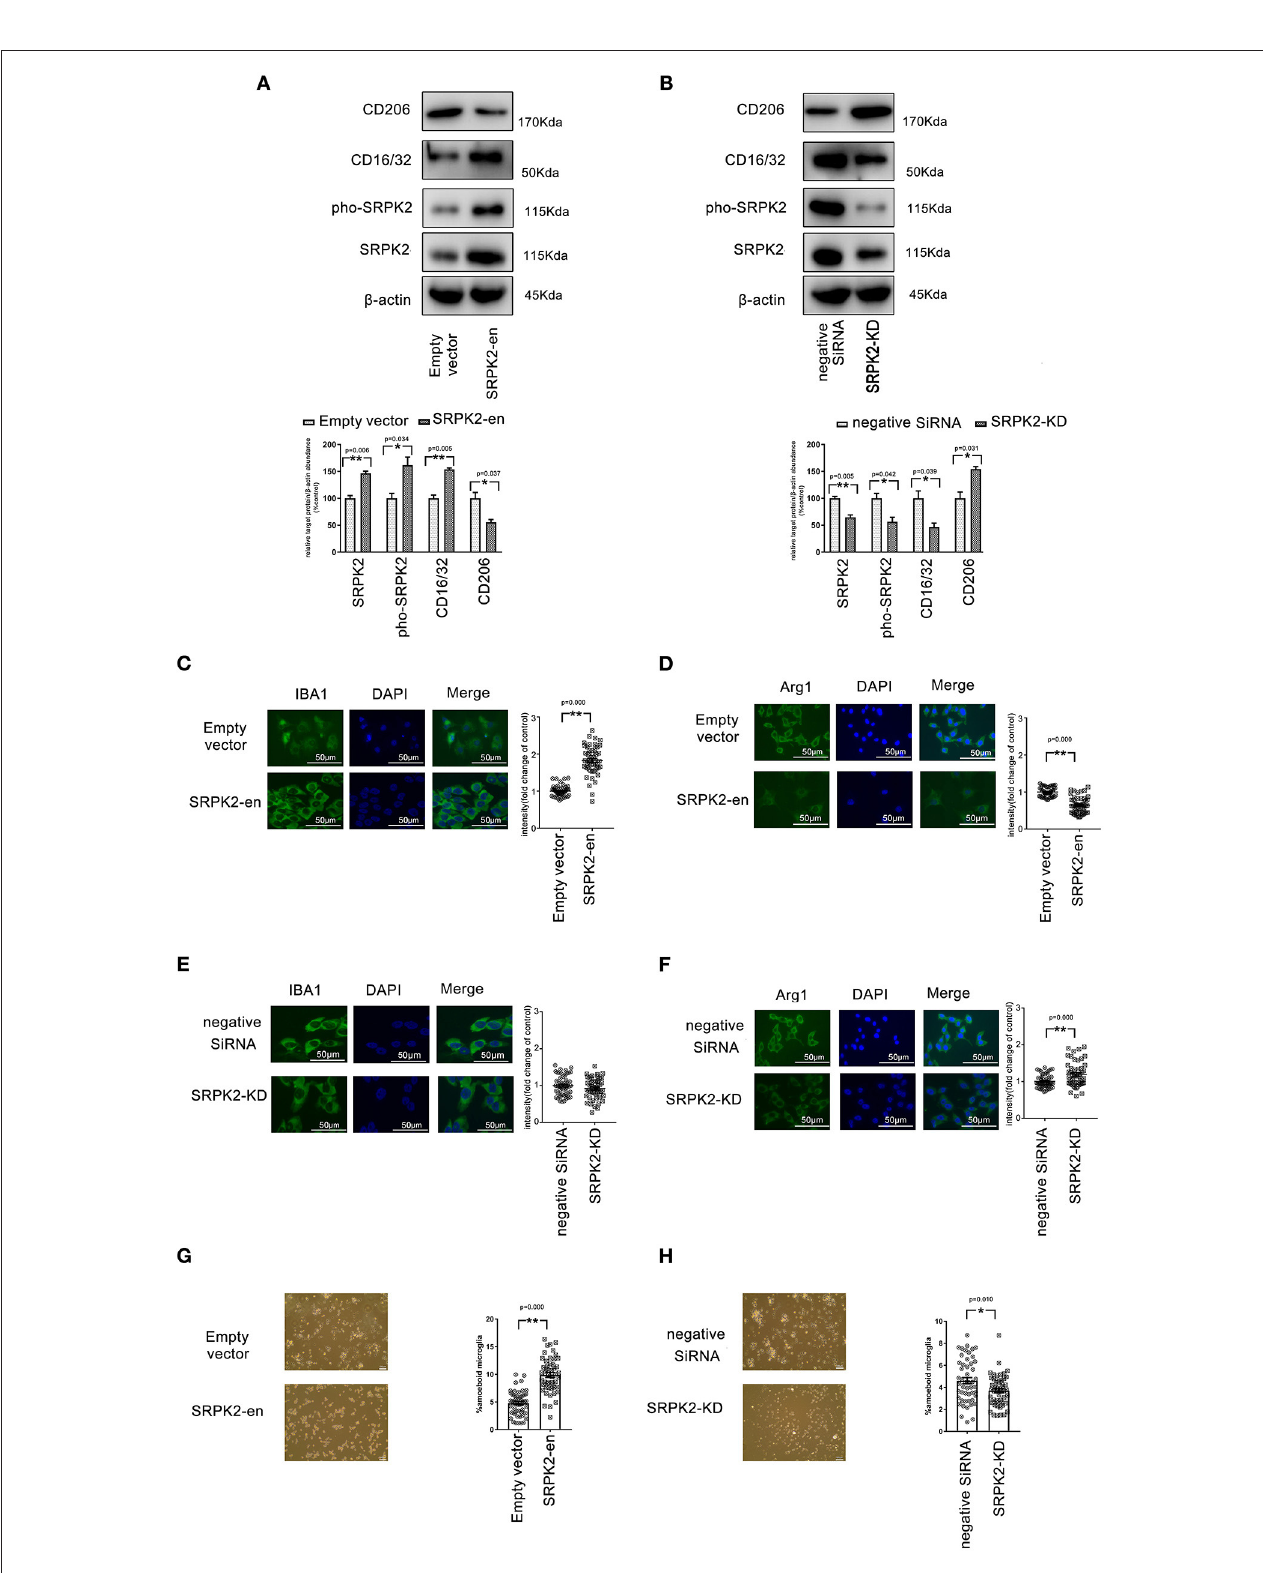
FIGURE 1 | The expression of serine/threonine-protein kinase 2 (SRPK2) contributed to the polarization of the M1 phenotype of the BV2 cells. The transfection of recombinant lentiviral vectors (SRPK2-en) increased the SRPK2 expression and the phosphated SRPK2 level in the BV2 cells compared to the transfection of empty vectors (A) , while the knockdown of SRPK2 by the transfection of small interfering RNA (siRNA) (SRPK2-KD) inhibited SRPK2 expression and the phosphated SRPK2